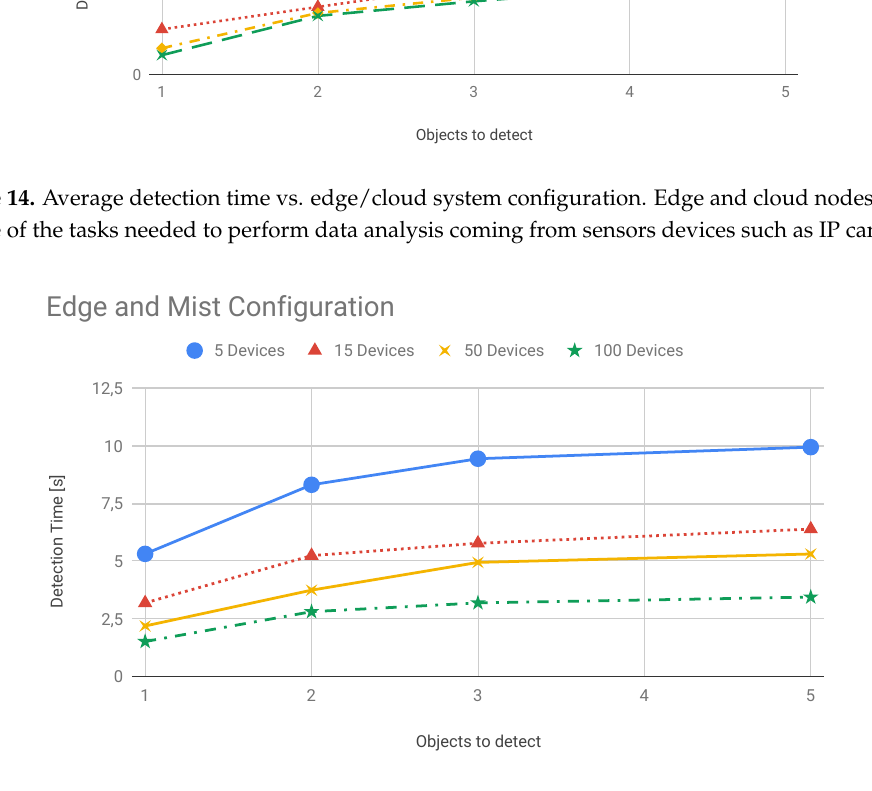
Figure 15. Average detection time vs. fully decentralized system configuration. Here, smart IP cameras are taking in charge of the detection process. Edge nodes receive post-elaborated data with information about detected